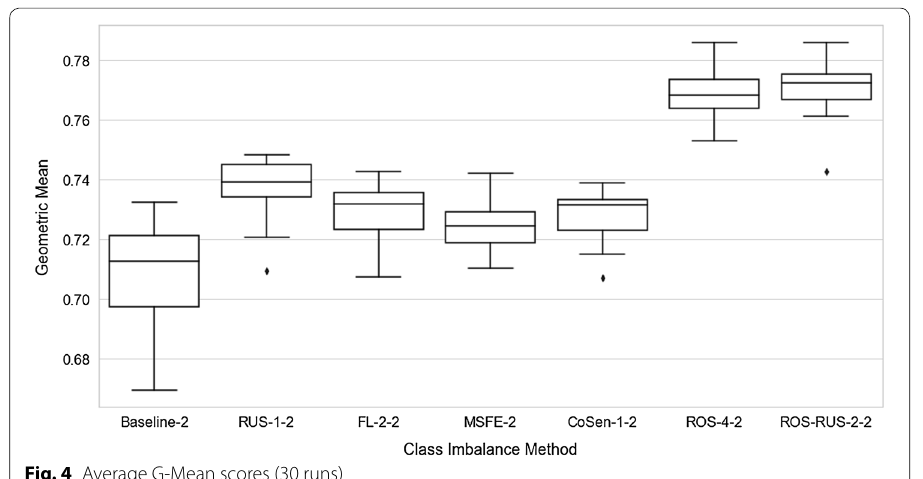
Fig. 4 Average G-Mean scores (30